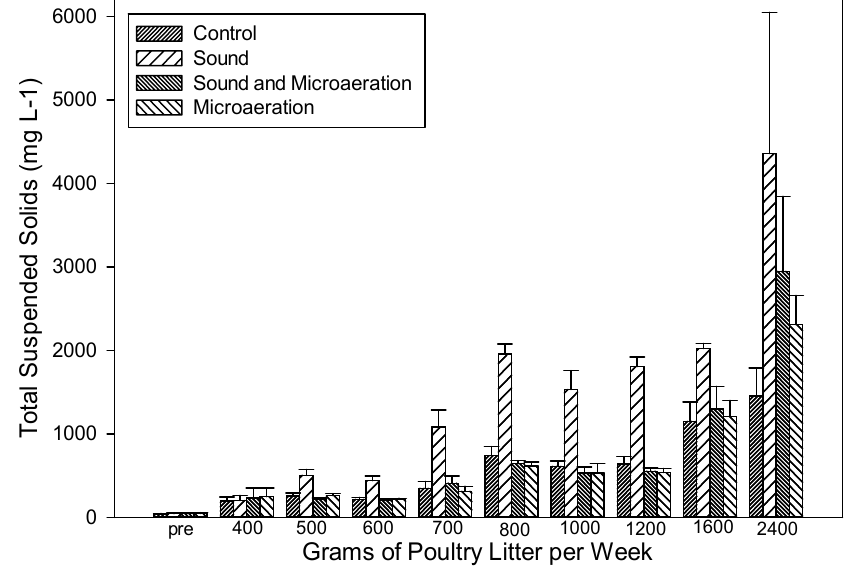
Figure 3. Total suspended solids in digestate. Data represent the mean and standard error of the mean.